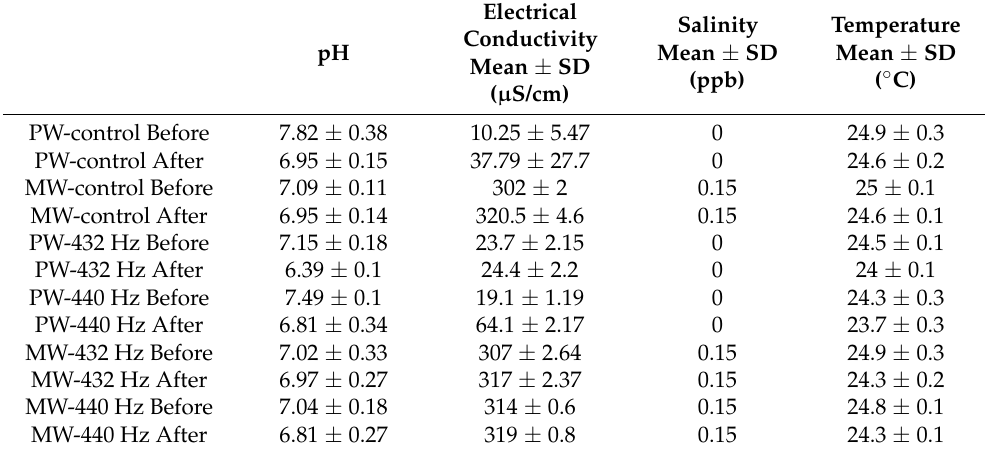
Table 1. Measured water parameters, each presented with its mean and standard deviation (SD), with increase in value stability for the perturbed waters, compared to the control ones in general also having higher standard deviations. A similar trend in changes was seen through all the samples. Electrical Salinity Conductivity pH Mean ± SD ( µ S/cm) PW-control